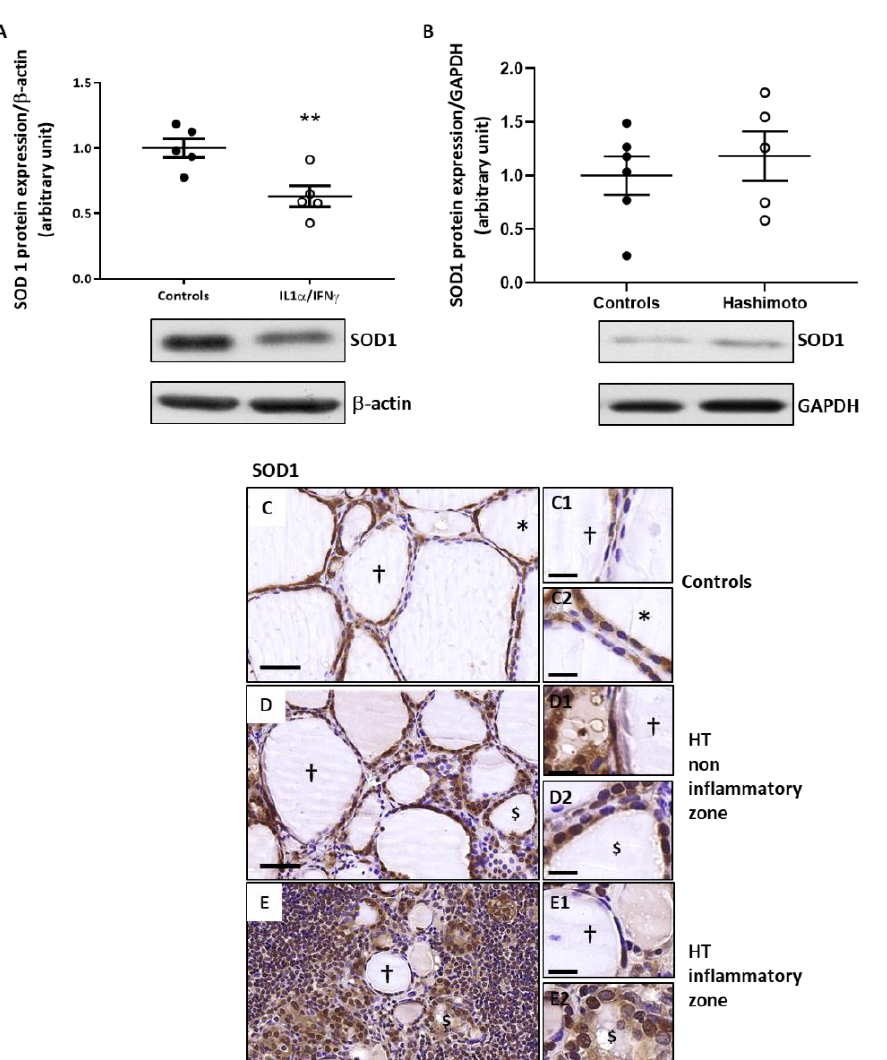
Figure 4. SOD1 protein expression was decreased by Th1 cytokines and unchanged in HT thyroid samples. Human thyrocytes treated with Th1 cytokines showed a significant reduction of SOD1 expression compared to non-treated cells ( A ). Densitometric values were normalized against β-actin level. Results are expressed as means ± SEM from five experiments ( n = 5) at least in duplicate. ** p < 0.01 compared to controls. ( B ) In HT thyroids, SOD1 expression was similar to controls. Densitometric values were normalized against GAPDH level. Values are expressed as means ± SEM from five or six individual samples ( n = 5–6). Representative blots are shown. SOD1 immunostaining was similar in control ( C ) and HT thyroids ( D , E ). Images shown are representative of each condition. ( C – E ) Scale bar = 50 µm. ( C1 – E2 ) Scale bar = 20 µm. (†) hypofunctional follicles, ($) altered active- like